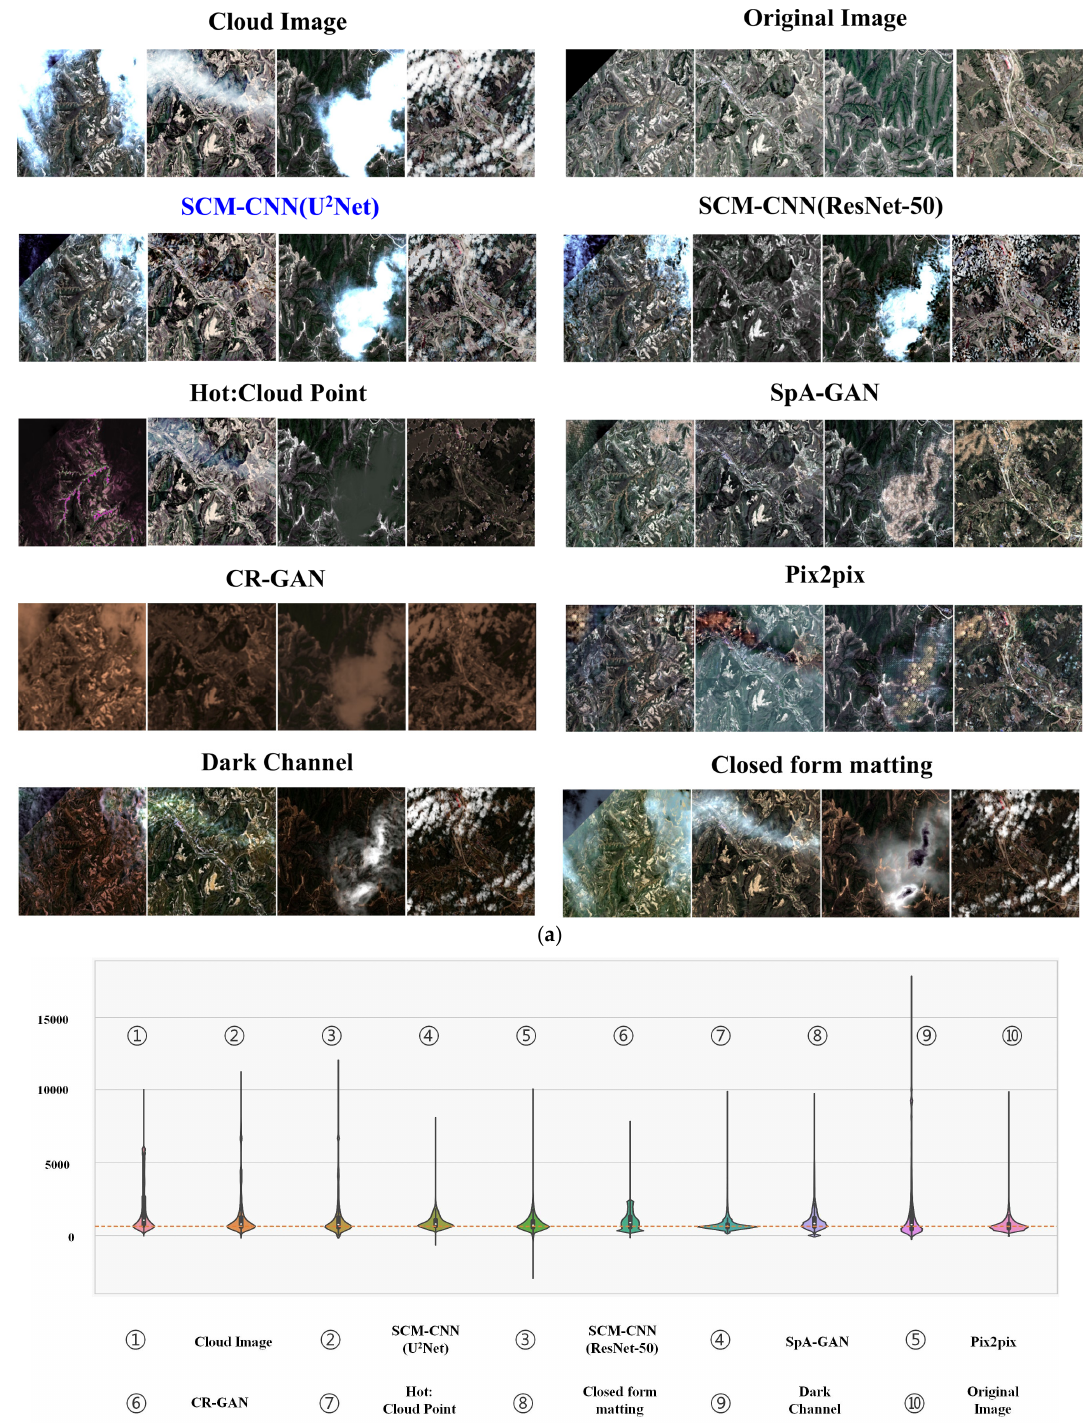
Figure 5. ( a ) Comparison of cloud removal results of various methods applied to RS image slices. ( b ) The violin diagram depicts the pixel distribution of cloud removal outcomes generated by various approaches and illustrates the features of pixel dispersion. The orange dashed line indicates the primary image element distribution of the original image and the primary image distribution of cloudy RS images. The primary distribution of cloud removal findings should be located on this dashed line.